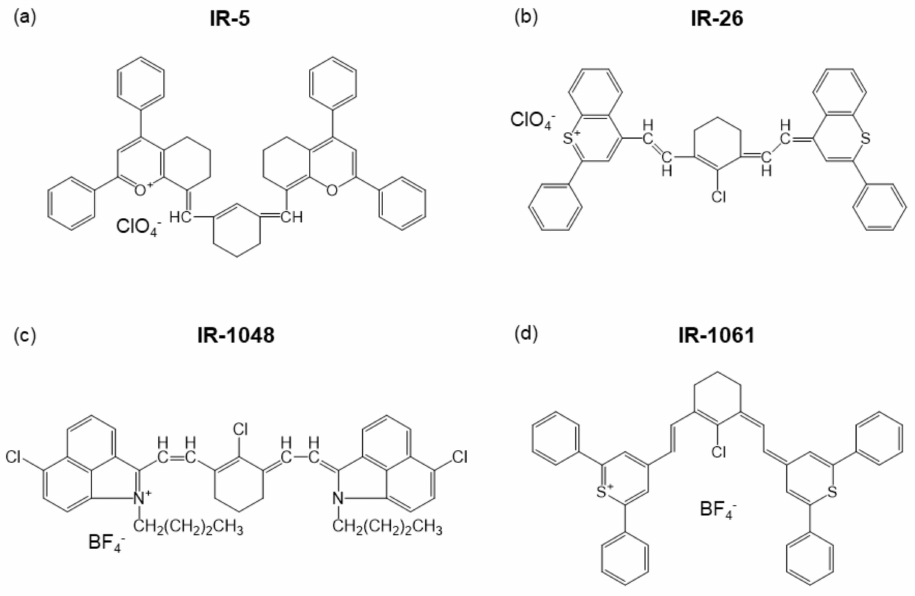
Figure 1. Examples of NIR laser dyes, ( a ) IR-5, ( b ) IR-26, ( c ) IR-1048, and ( d ) IR-1061. To control heat absorption and emission, regardless of whether it is organic or in- organic, we should pay attention to the energy of vibration, (cid:125) ω , and the polarity of the space created by the atoms, ions, and molecules surrounding the luminescence center. The smaller the vibration energy and polarity, the less heat will be emitted. In the following sections, we discuss the application of nanostructures in which ions and molecules are hybridized and designed for NIR biomedical photonics based on these